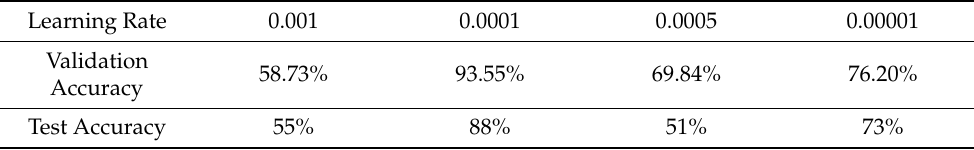
Table 2. Validation accuracy at different learning